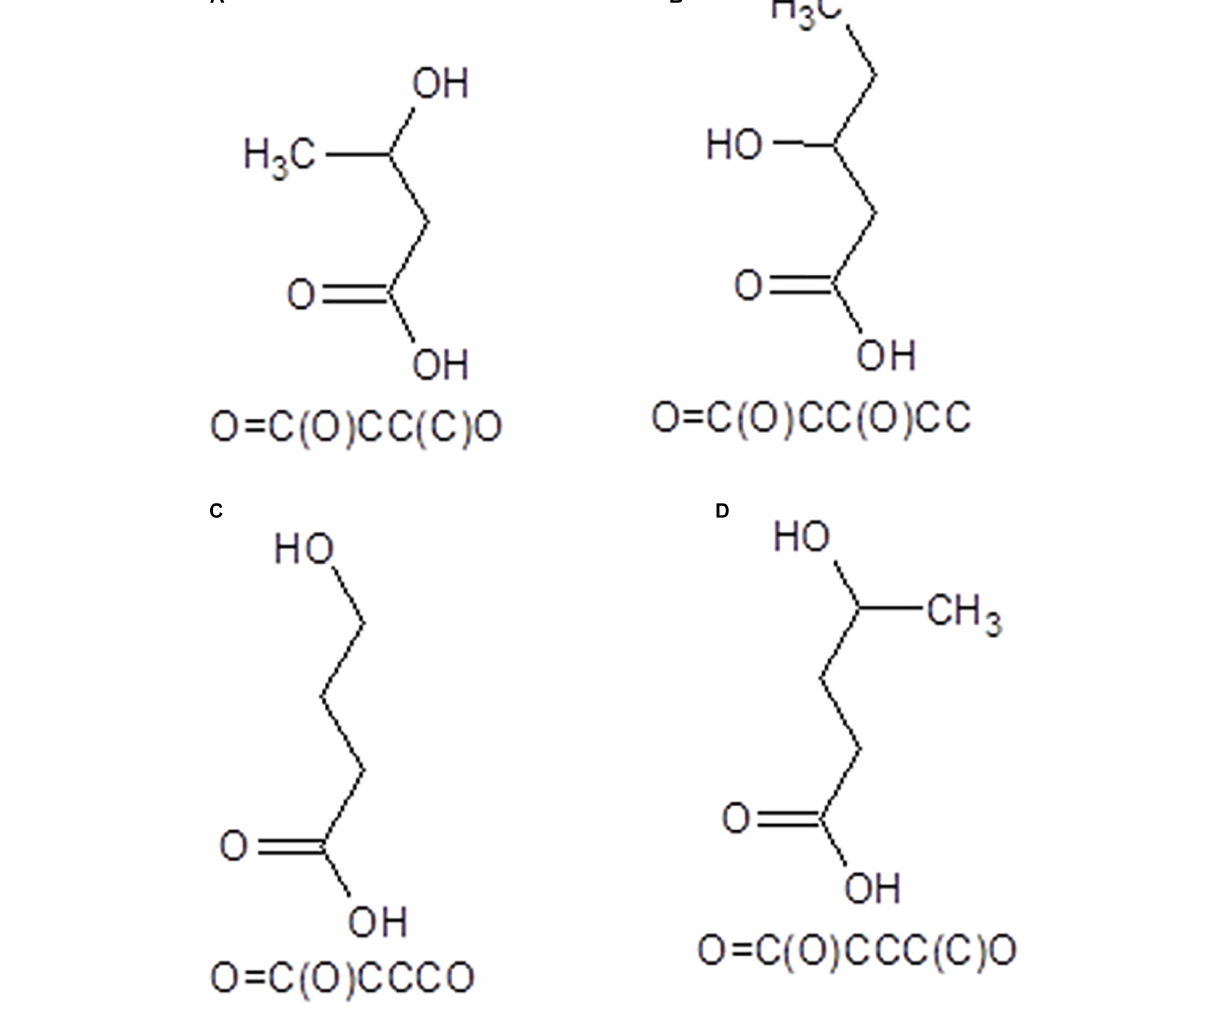
Frontiers in Bioengineering and Biotechnology |